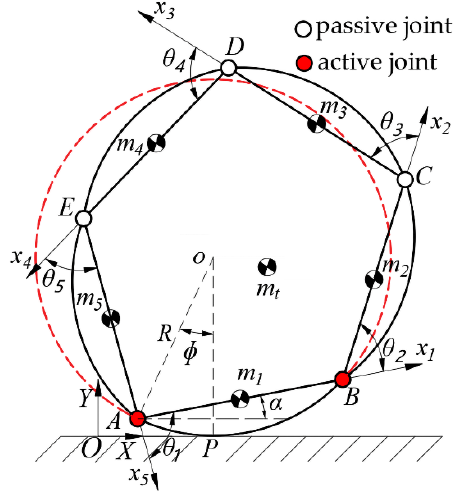
Figure 2. Kinematics analytical model.